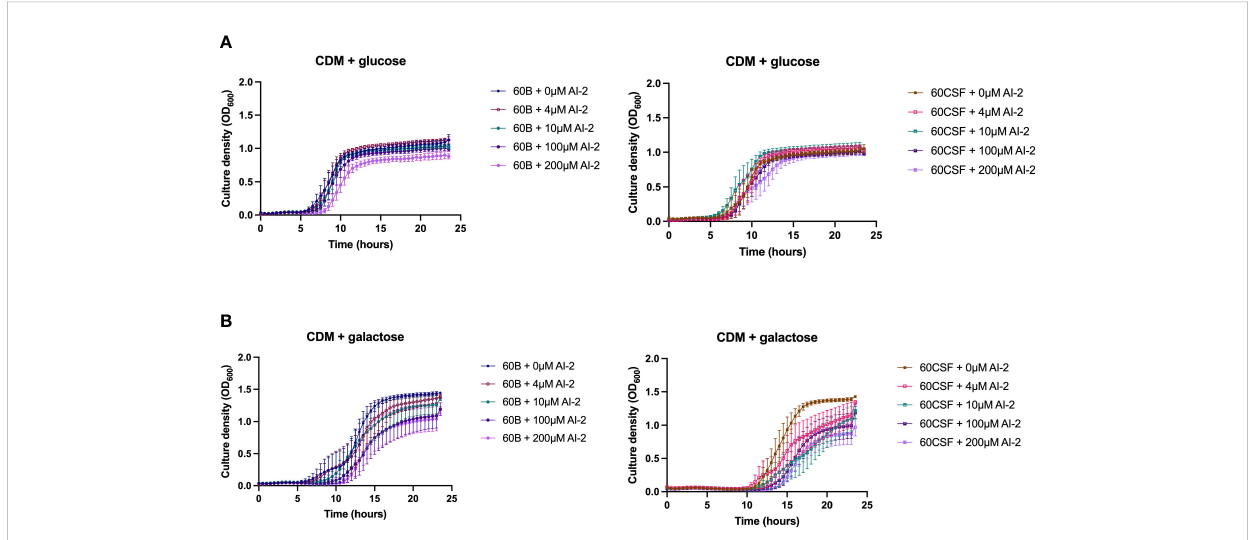
FIGURE 5 Growth of 60B and 60CSF with AI-2 supplementation at different concentrations. 60B and 60CSF were cultured in CDM + glucose (A) or CDM + galactose (B) supplemented with 0, 4, 10, 100 or 200 µM. OD 600 was measured every 30 min for 24 (h) Data are mean OD 600 ± standard error mean (SEM) from three independent assays, each performed in triplicate.